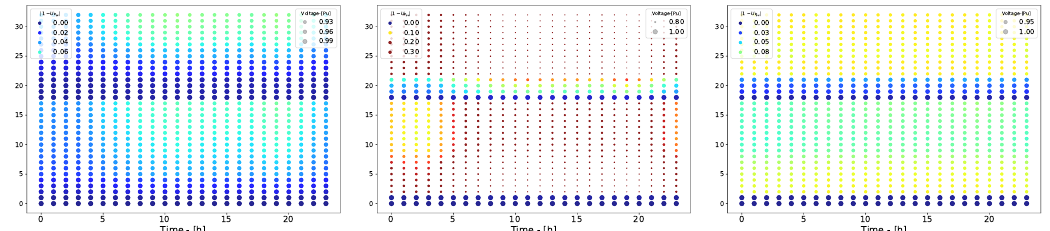
Figure 10. Bus voltages for different days and hours considering: the normal operation, a contingency when line 1-2 is out of service, and the results of load shedding using the proposed methodology for the same contingency.